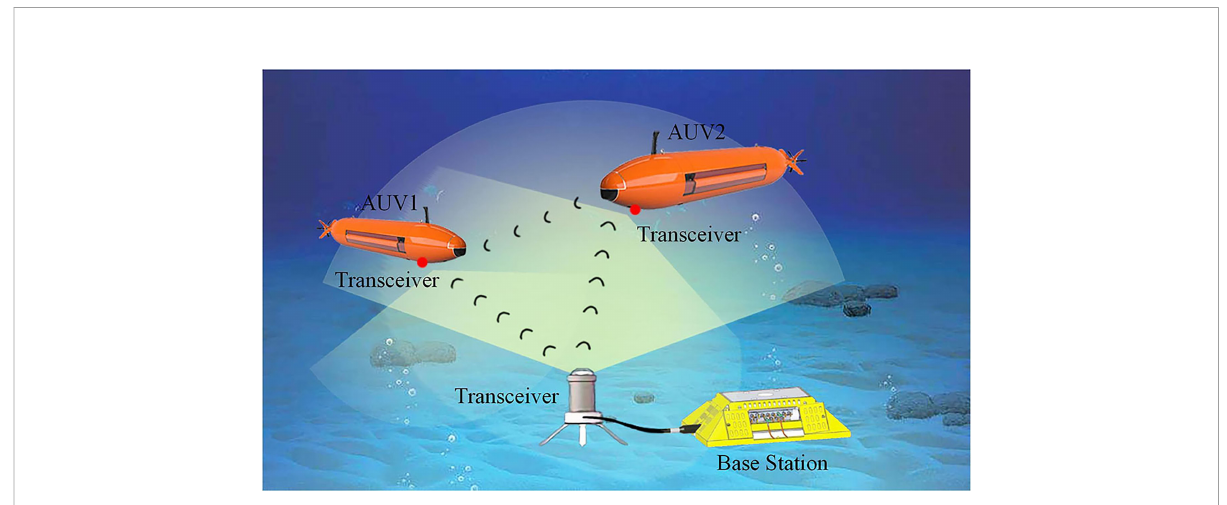
FIGURE 1 Schematic diagram of the seabed communication of